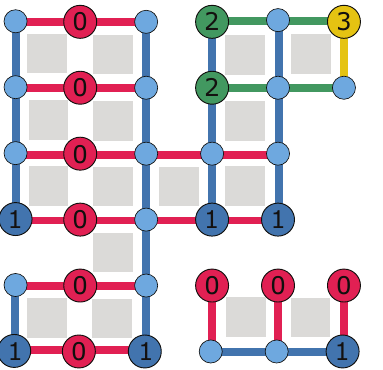
FIG. 9. An illustration of the initial state preparation for a module with two sets of connected lines. Only implicitly enforced constraints are shown. The line colors and numbers indicate the priority P μ of a line, with the highlighted qubits showing an example of where the physical ˆ σ z rotations may be implemented. Rotations on lines with higher priority must be performed